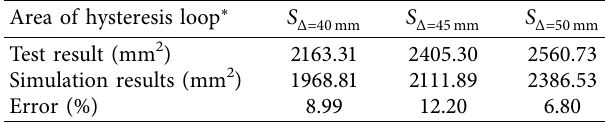
Figure 11: The hysteretic curve compares between the simulation and experiment. Table 8: The energy dissipation capacity between the simulation and experiment.